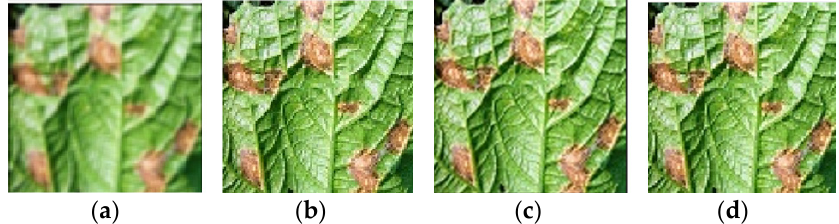
Figure 3. Dilated convolution images: ( a ) original image; ( b ) rate = 1; ( c ) rate = 2; ( d ) rate = 3.